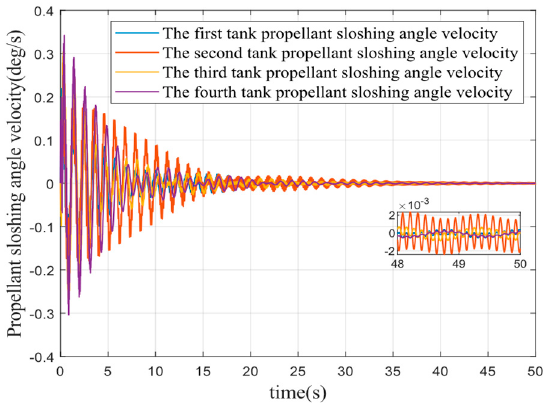
Figure 22. Angular velocity of liquid fuel sloshing with considering external disturbances.